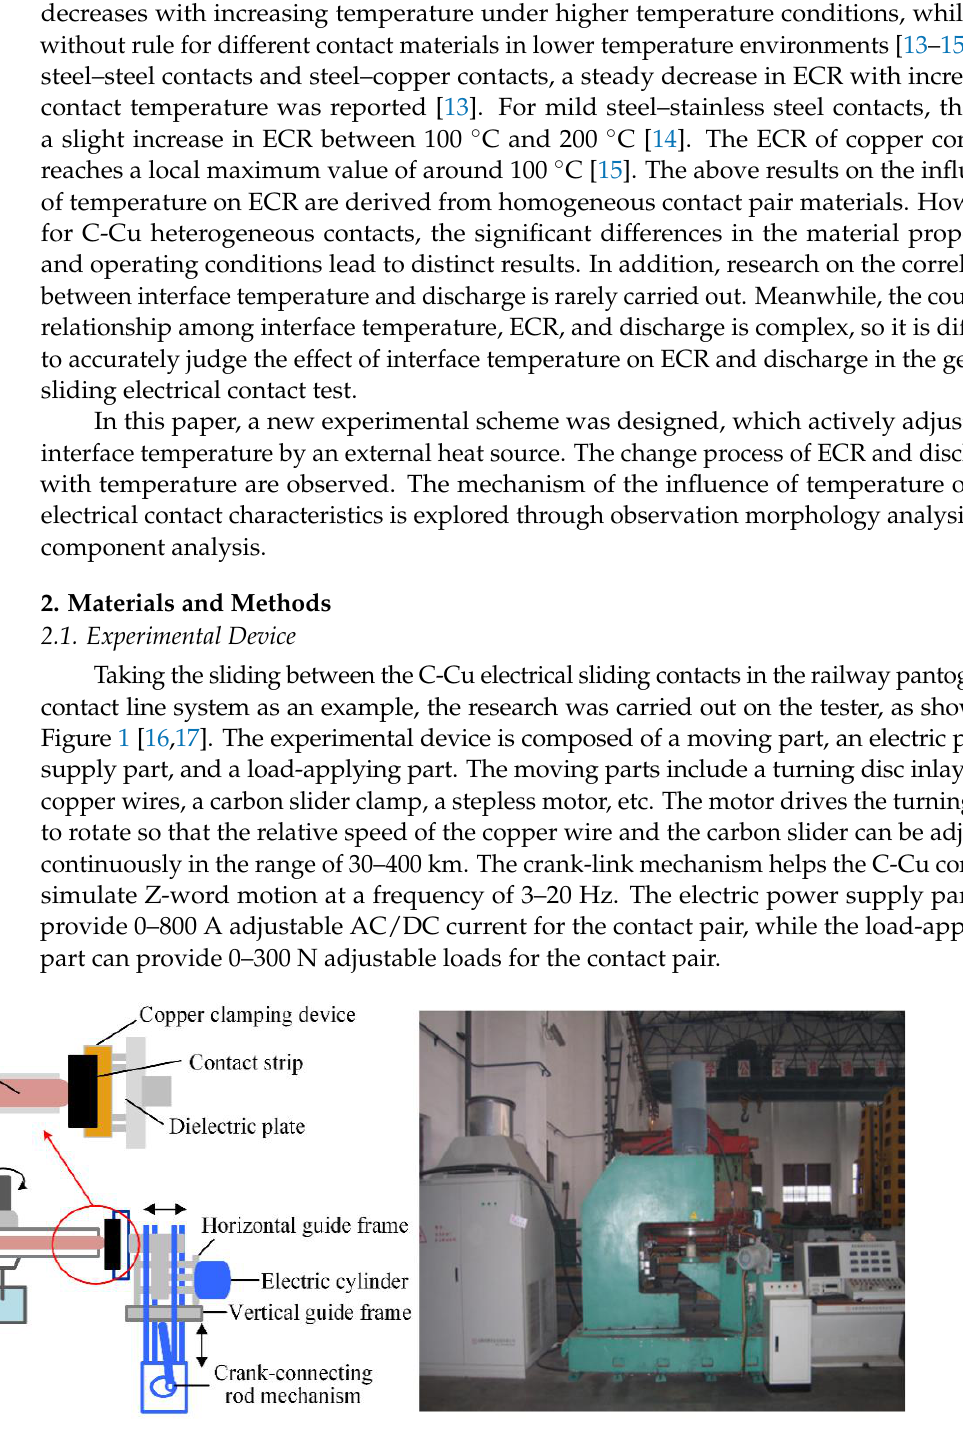
Figure 1. Schematic diagram of the high-speed current-carrying friction and wear tester.